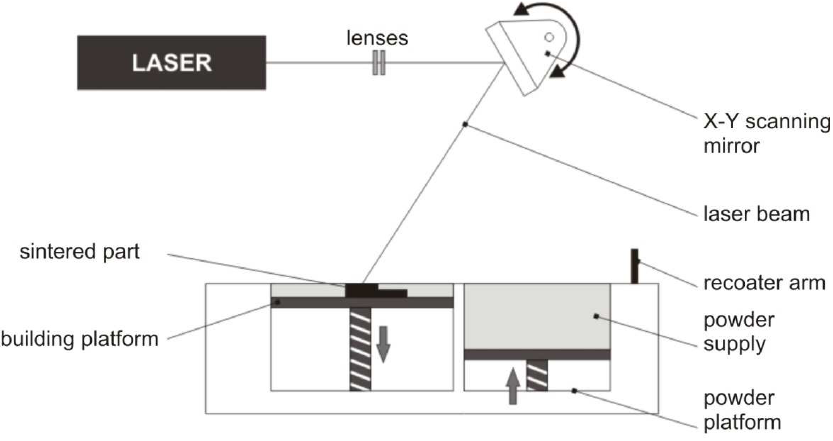
Figure 2 – DMLS Technology